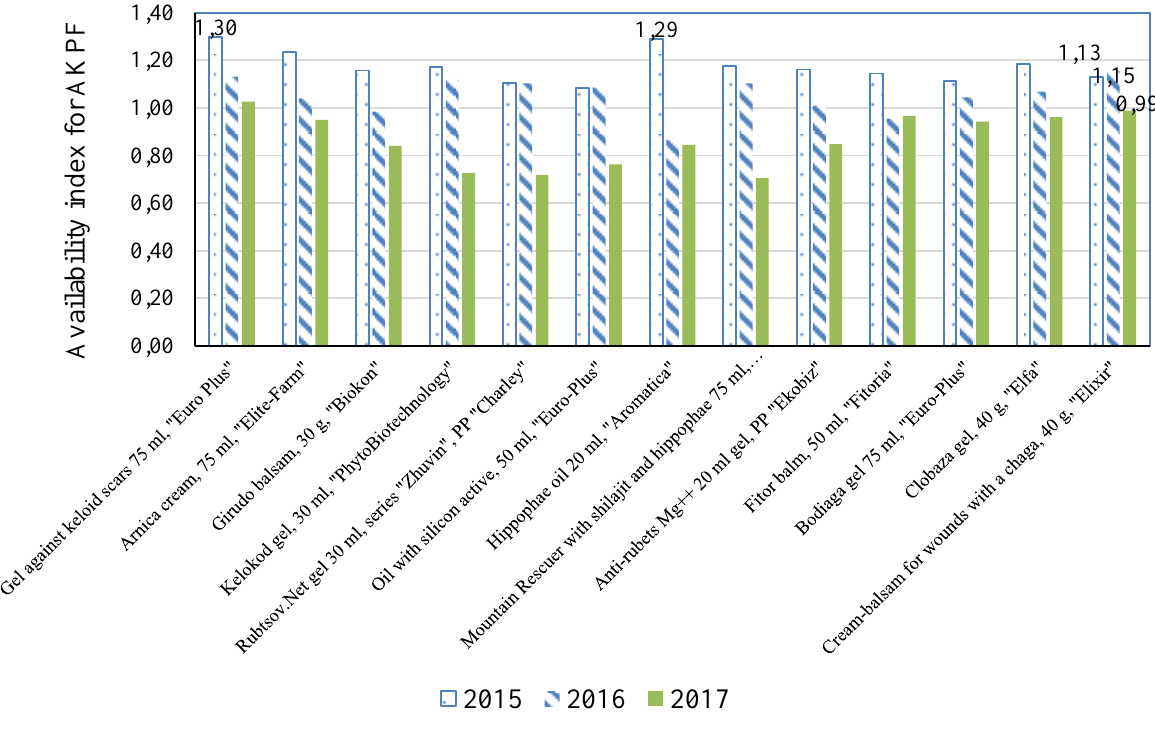
Fig. 5. Availability index for AKPF in